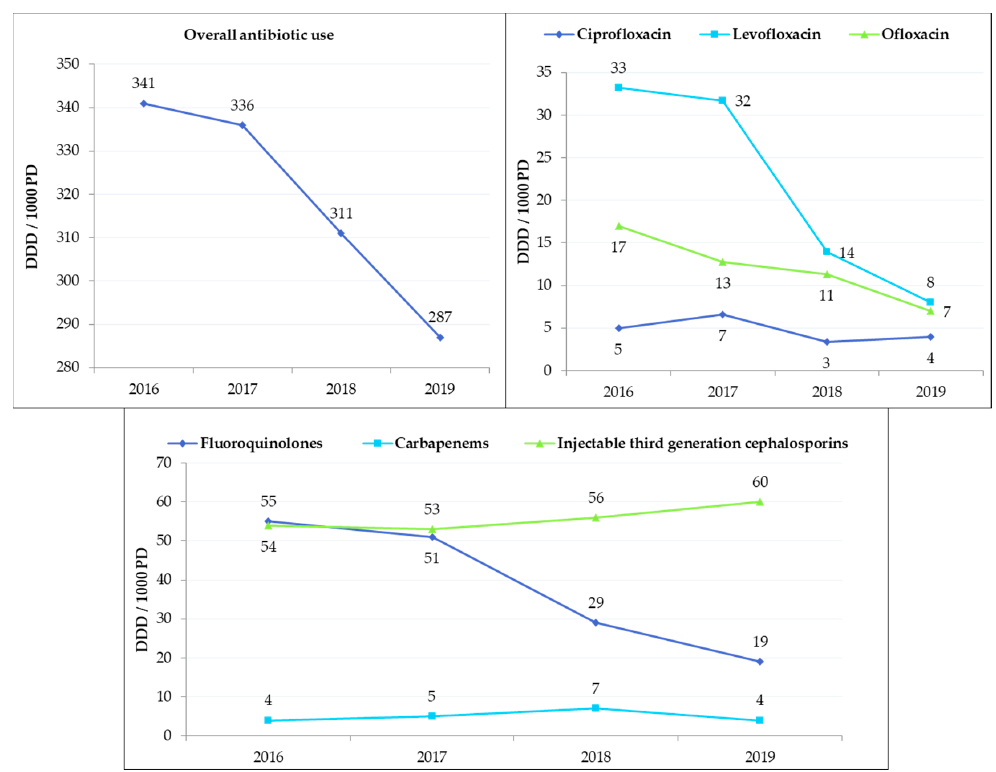
Figure 5. Evolution over time of antibiotic consumption in secondary care hospital of Bassin de Thau. Data are presented as defined daily dose of antibiotics per 1000 patient-days (DDD 1000PD ).